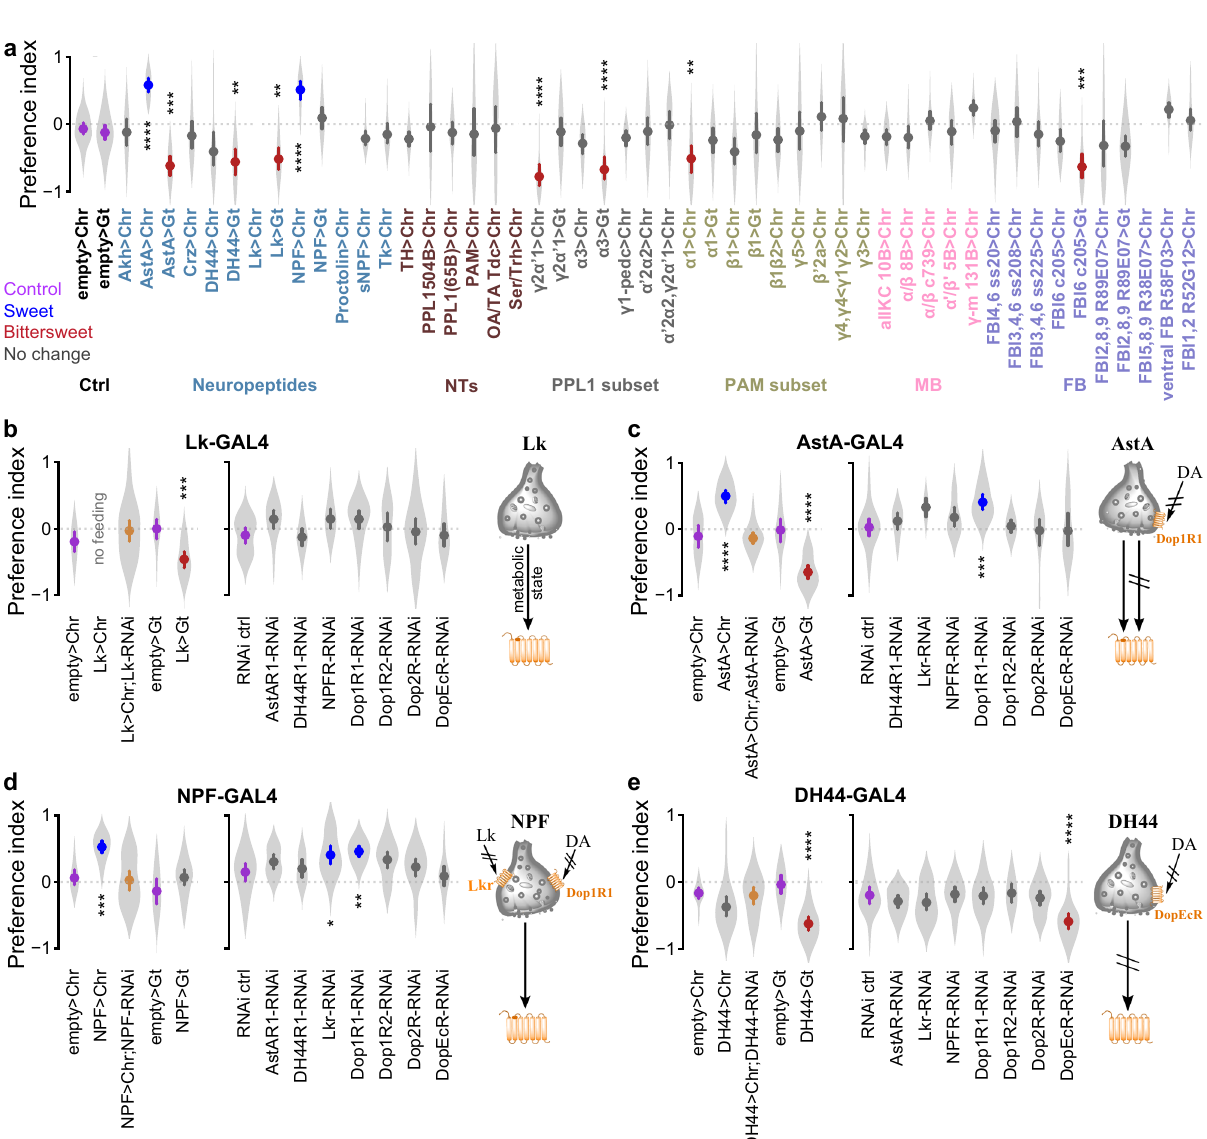
Fig. 2 A decision making neuronal ensemble revealed by combined optogenetic and chemoconnectomic strategy. a Cell-speci fi c optogenetic activation and inhibition screen was performed at the equal preference condition (50 mM sucrose vs. 500 mM sucrose + 1 mM quinine) using fl ies deprived of food for 21 h. Neuronal subsets were genetically targeted using the GAL4-UAS binary expression system. Red-light-sensitive CsChrimson (Chr) was used for optogenetic activation and green-light-sensitive GtACR1 (Gt) for optogenetic silencing. Optogenetic manipulation of AstA, DH44, Lk, and NPF neuropeptides; PPL1 γ 2 α ’ 1, PPL1 α 3, and PAM α 1 dopaminergic subsets; and fan-shaped body layer 6 neurons (FBl6) signi fi cantly shifted preference away from equal preference compared to respective empty>Chr and empty>Gt controls. Purple mean point = control, blue mean point = signi fi cant sweet preference, red mean point = signi fi cant bittersweet preference, yellow mean point = simultaneous optogenetic activation and RNAi. b (left) Optogenetic activation of Leucokinin (Lk) neurons suppressed feeding in food deprived fl ies, while optogenetic inhibition shifted the preference towards bittersweet. Simultaneous Lk RNAi in Lk neurons abolished the suppression of feeding induced by optogenetic activation. b (right) RNAi in Lk neurons of analogous receptors for other candidate neuromodulators had no effect. c (left) Optogenetic a c tivation of Allatostatin A (AstA) neurons shifted preference towards sweet while optogenetic inhibition shifted it towards bittersweet. Simultaneous AstA RNAi abolished the preference shift induced by optogenetic activation. c (right) Dop1R1 RNAi in AstA neurons shifted preference towards sweet. d (left) Optogenetic activation of NPF neurons shifted preference towards sweet. Simultaneous NPF RNAi abolished the preference shift induced by optogenetic activation. d (right) Lkr or Dop1R1 RNAi in NPF neurons each shifted preference towards sweet. e (left) Optogenetic activation of DH44 neurons had no effect on preference, while optogenetic inhibition shifted preference toward bittersweet. e (right) DopEcR RNAi in DH44 neurons shifted preference towards bittersweet. Schematics summarize the decision relevant information fl ow for speci fi c neuropeptides. Plots show mean ± 95% CI, with violins depicting full data distribution; 5 ≤ trials ≤ 30 per violin, mode = 10. See Supplementary Table 1 for sample size and statistics. p < 0.00001 = ****, p < 0.0001 = ***, p < 0.01 = **, p < 0.05 =